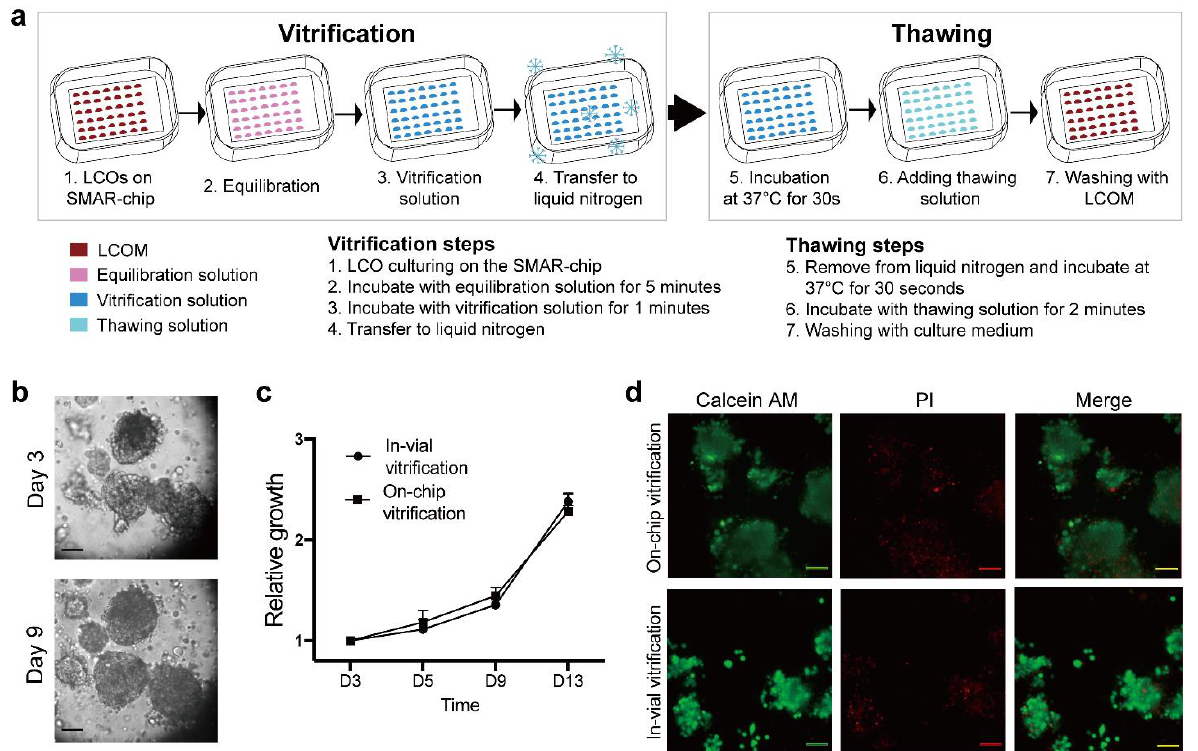
Figure 5. Illustration of the in situ vitrification-thaw method. ( a ) Diagram showing the procedures of the in situ vitrification–thawing cycle on the SMAR-chip. ( b ) Images of the LCOs after the in situ vitrification–thawing cycle. ( c ) Growth rates of LCOs underwent the vitrification–thawing cycle on the SMAR-chip and in the cryovial. ( d ) Images of the live–dead cell staining of LCOs underwent the on-chip and in-vial vitrification. Scales bars: 100 µm.